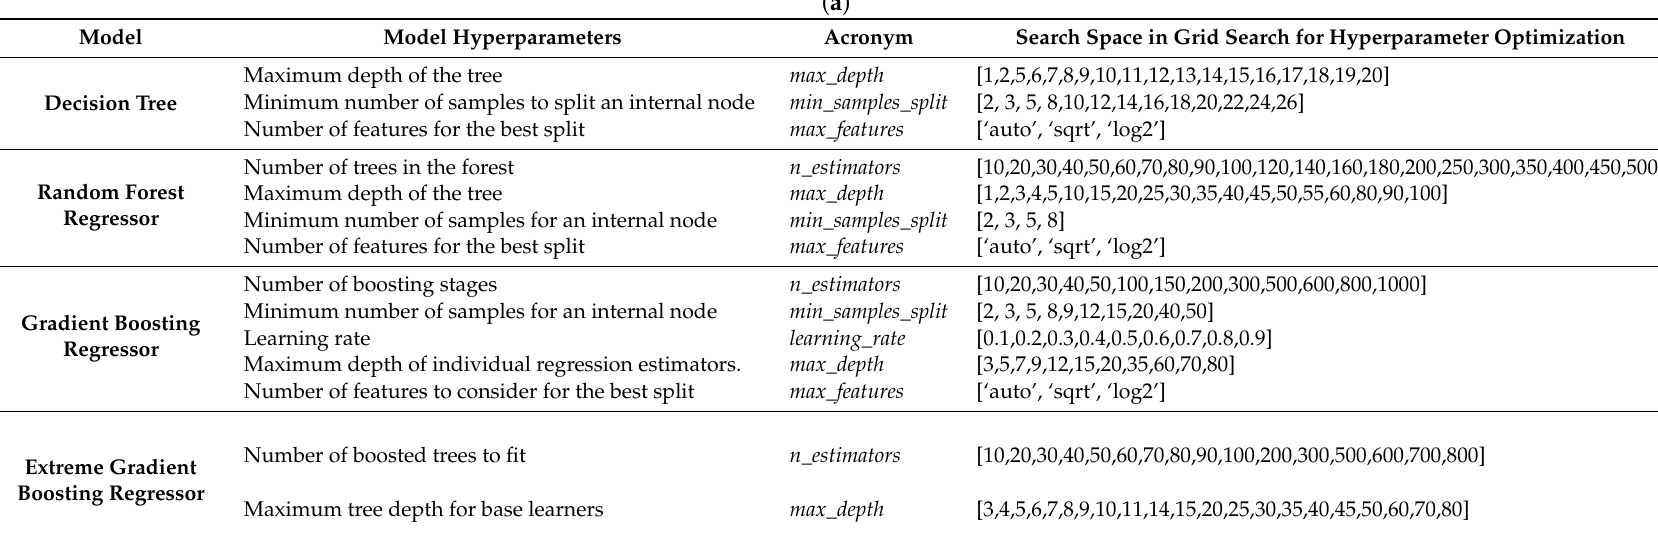
Table 5. ( a ) Architecture of the decision tree and ensemble-based models developed for GSR prediction. ( b ) Optimum hyperparameters after grid search for each solar city, Australia (Blacktown, Central Victoria, Adelaide, and